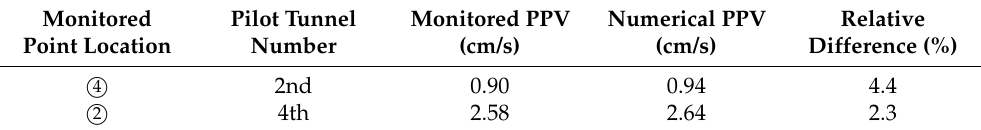
Table 3. Comparison of monitored data and numerical results.